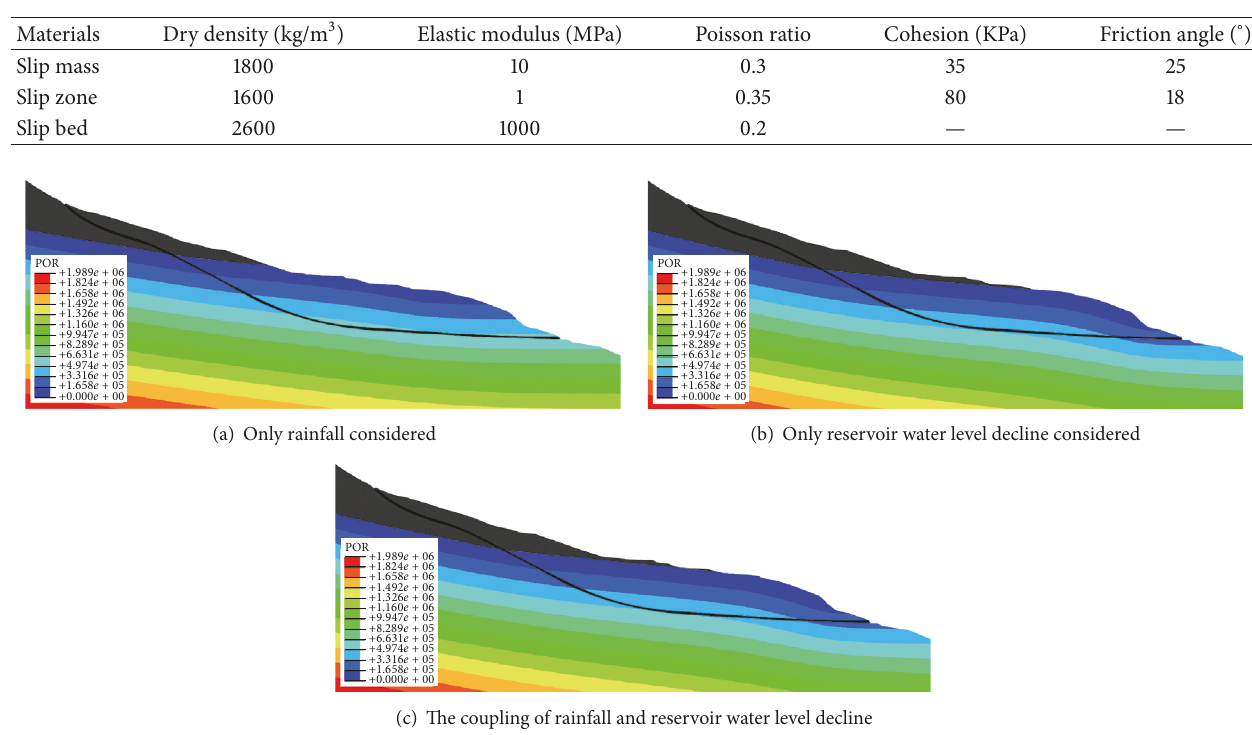
Table 2: Physicomechanical parameters of the Baijiabao landslide model.